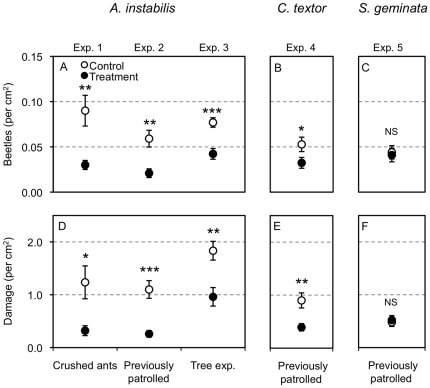
The effect of ant semiochemical treatments on beetle choice and herbivory.Experiments 1–5 treatment means (± SE) for the number of beetles per cm2 (A–C) and mean damage per cm2 (D–F). Specifically, Exp. 1 – crushed A. instabilis ant treatment versus control experiment (A,D), Exp. 2 -leaves previously patrolled by A. instabilis versus control experiment (A,D), Exp. 3 -leaves from trees with A. instabilis nests versus leaves from trees without nests (A,D), Exp. 4 -leaves previously patrolled by C. textor versus control leaves experiment (B,E), and Exp. 5 -leaves previously patrolled by S. geminata versus control leaves experiment (C,F). The x-axis represents the method of ant-treatment for each experiment. Statistical differences between ant and control treatment means are represented as: NS = P>0.05, * = P<0.05, ** = P<0.01, *** = P<0.001.